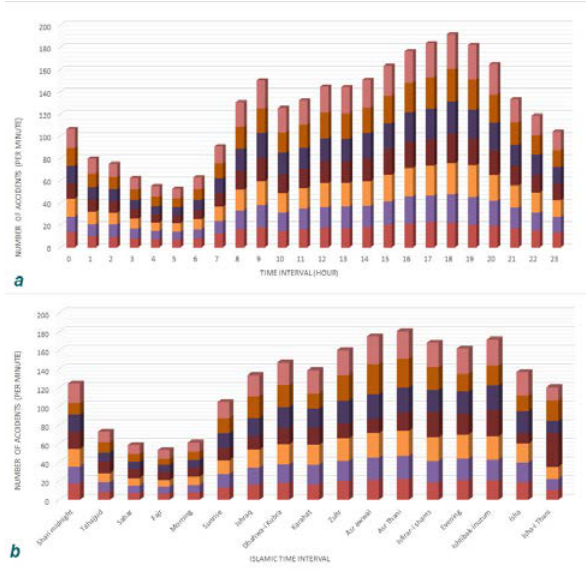
Figure 4. The number of accidents per minute, (a) local time; (b) Islamic time The percentages of the number of accidents in the time interval according to the total number of accidents are shown in Fig.